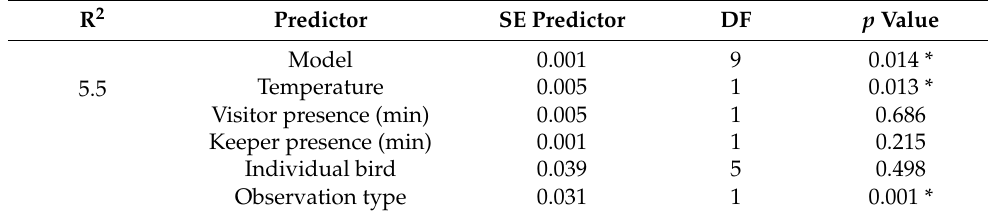
Table 4. Output of GLMM predictors for L. edwardsi SPI